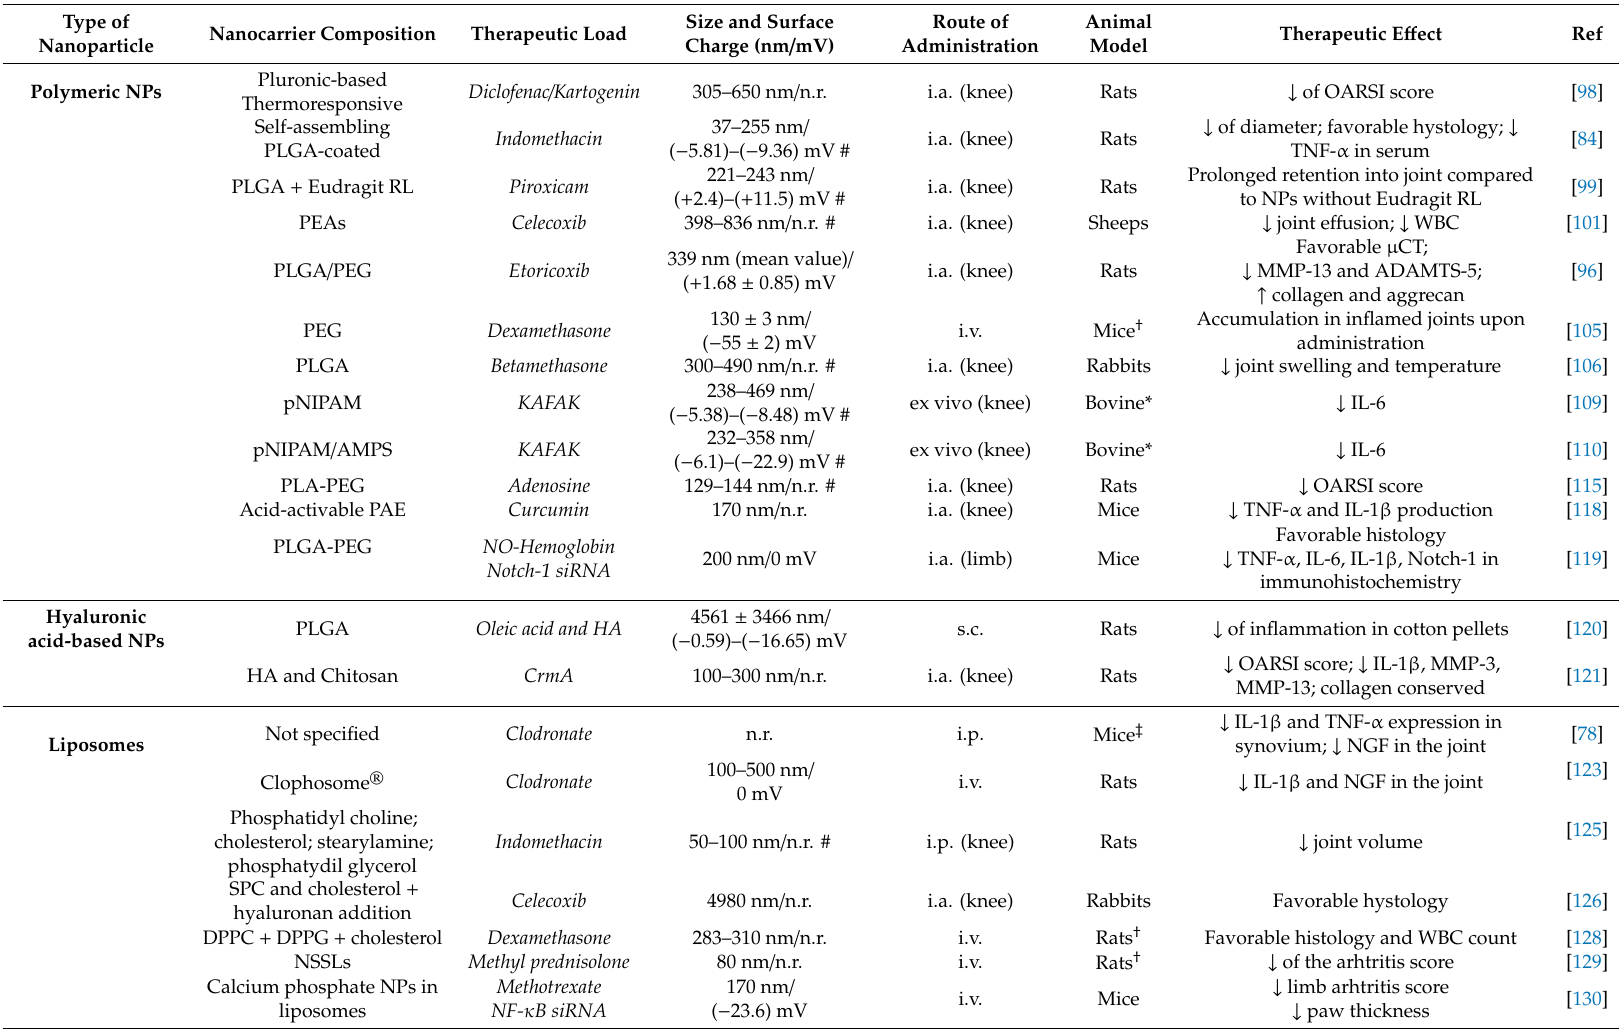
Table 1. Summary of nanoparticle-based approaches to target macrophages using in vivo pre-clinical models of osteoarthritis